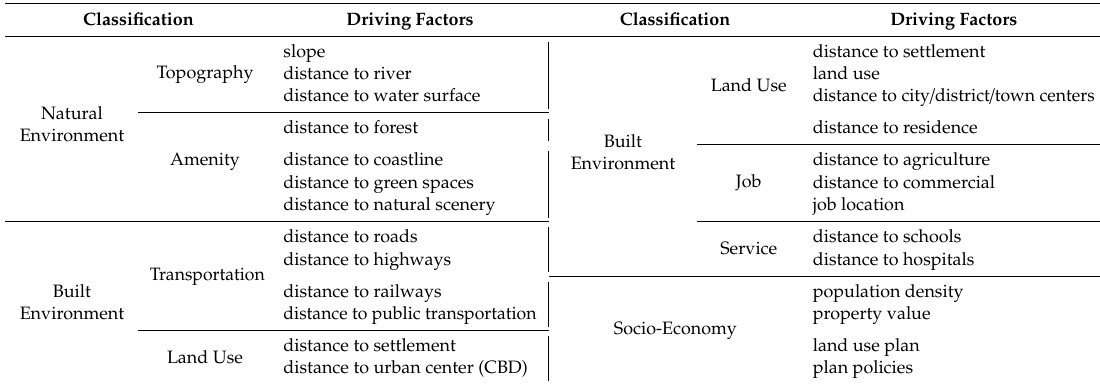
Table 1. List of key driving factors in empirical